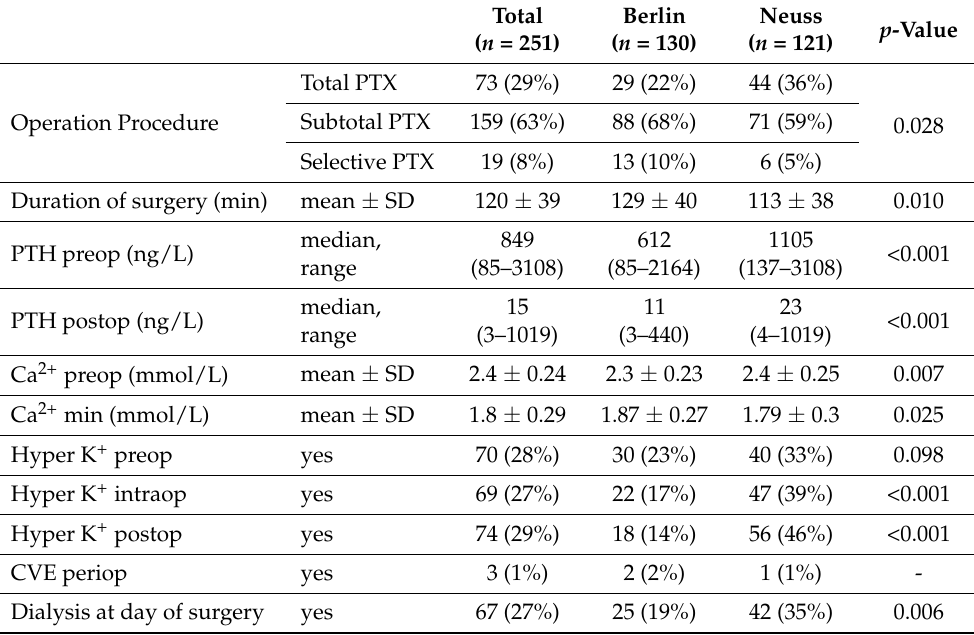
Table 2. Perioperative parameters and laboratory chemistry comparing both